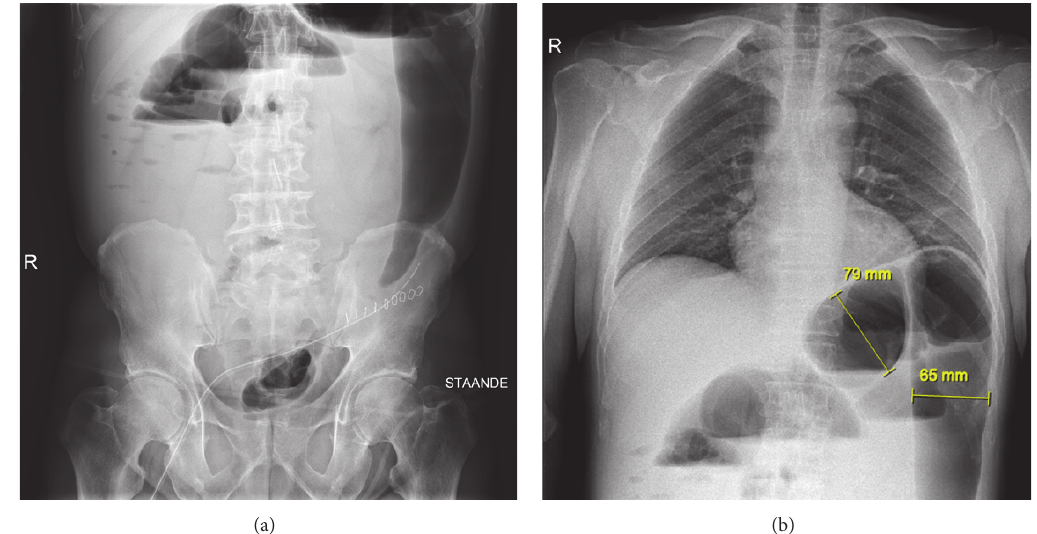
Figure 1: Plain X-ray in standing position showing aerocoly in the epigastric region and the splenic flexure. No evidence of free air under the diaphragm.